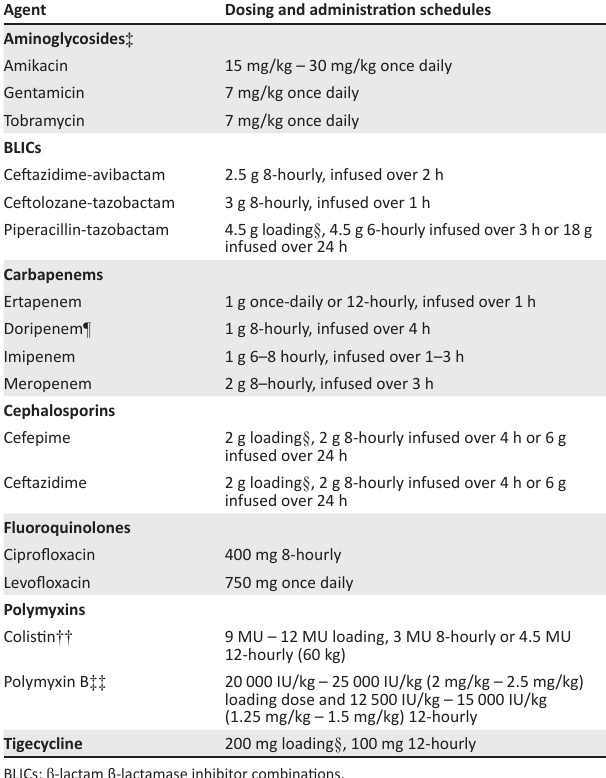
TABLE 4: Recommended intravenous antibiotic treatment options for carbapenem-resistant Enterobacterales . † , ‡